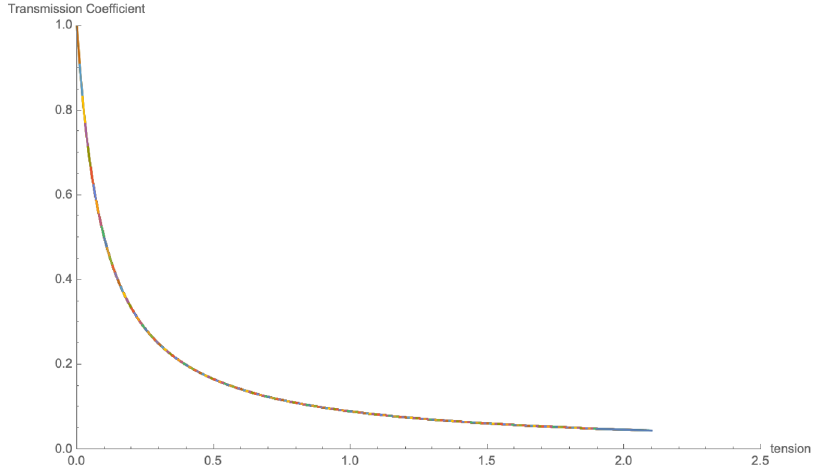
Figure 2 . Transmission coefficient for the 2-region holographic model for different l L and l R where l L /l R ranges from 0 . 05 to 20 .